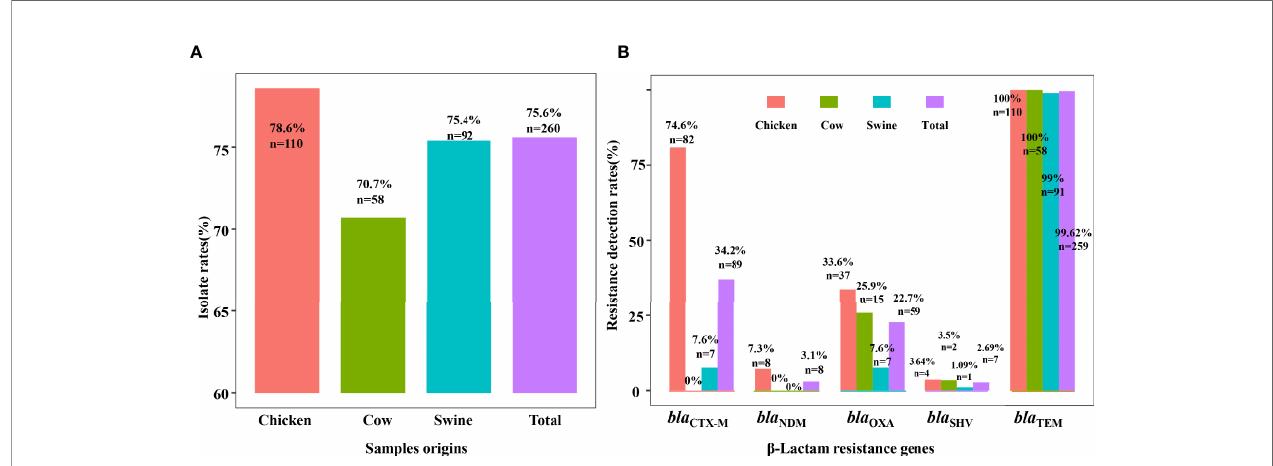
FIGURE 1 | The prevalence of ESBL-EC and b -lactam resistance genes. Detection rates of ESBL-EC are shown in (A) and the carriage rates of b -lactam resistance genes are shown in (B) . The bars showed the detection rates of resistant isolates or carriage rates of resistance genes in ESBL-EC among different food animals. In total, 260 isolates were detected from 344 samples, including 110 from chicken (red), 58 from cow (green), and 92 from swine